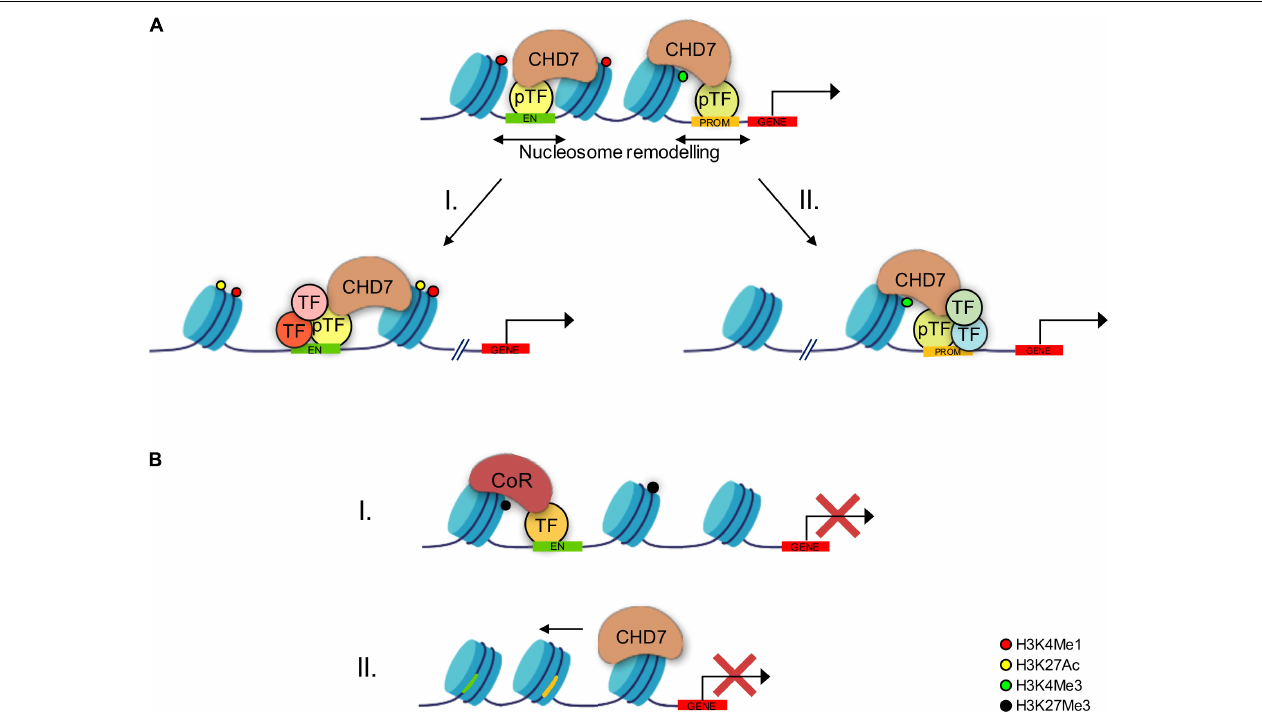
FIGURE 1 | Schematic drawing showing the mechanisms through which CHD7 controls gene expression. (A) CHD7 is predominantly recruited at active enhancers (H3K4me1 mark, red dots) and, even if with less extent, promoters (H3K4Me3 mark, green dots) by the presence of pioneer transcription factors and specific histone methylations. The CHD7-induced chromatin opening via nucleosome remodeling allows regulatory elements to become more accessible to additional transcription factors (TFs) at both enhancers (I) and promoters (II). Furthermore, co-activators, such as histone acetylases, may be recruited as well at enhancer sites (I), thus promoting further histone modifications (H3K27ac, yellow dots) associated with enhanced transcription activity. (B) CHD7 can also act as transcription repressor. Chromatin remodeling might result in TFs complexed with co-repressors that promote repressive histone modification (H3K27me3, black dot) (I). Conversely, CHD7 might promote nucleosome repositioning, resulting in less accessible chromatin and in decreased transcriptional activity